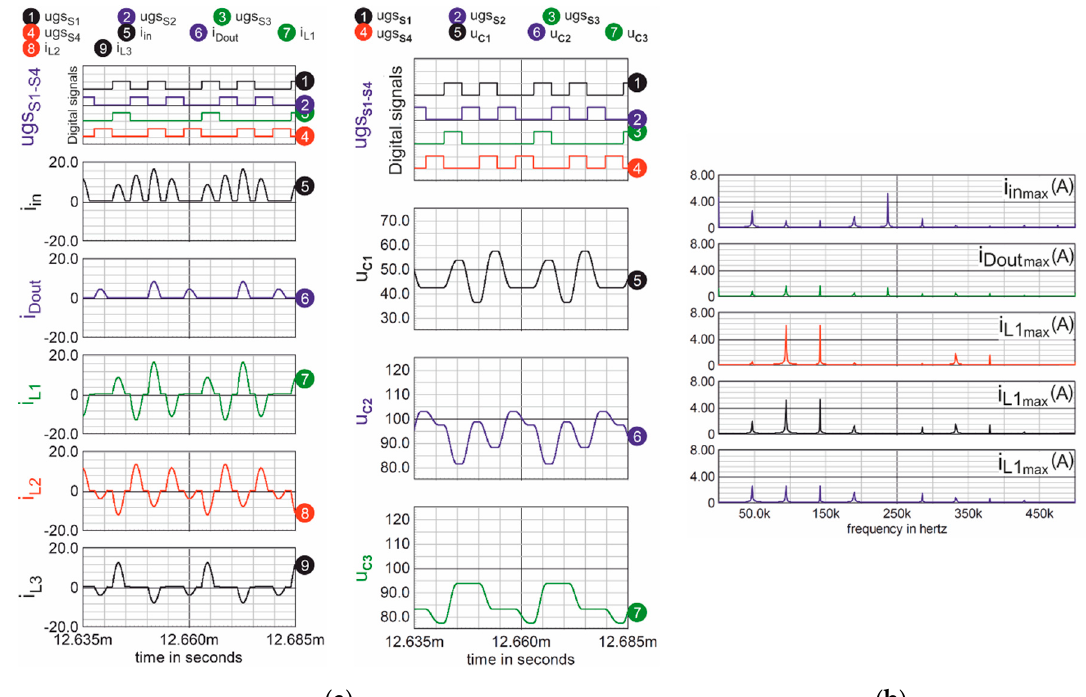
Figure 2. Steady-state operation of the LCSCVMa converter under switching strategy C1: ( a ) waveforms of the gate to source signals of transistors (presented with level shift), input current (in amperes), and voltages (in volts) on capacitors C 1 , C 2 , and C 3 . ( b ) Spectrum of the input current, and currents of switched capacitors and output capacitor. The results were obtained with the use of ICAP/4 simulation software.